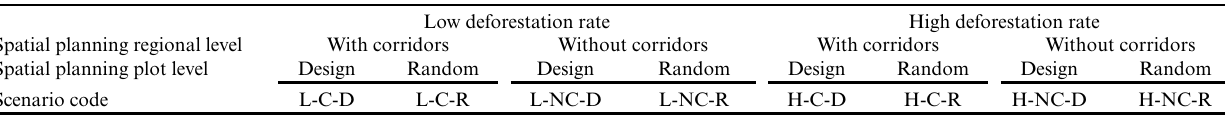
Table 1. Deforestation scenarios simulated for the province of Formosa in the Argentine